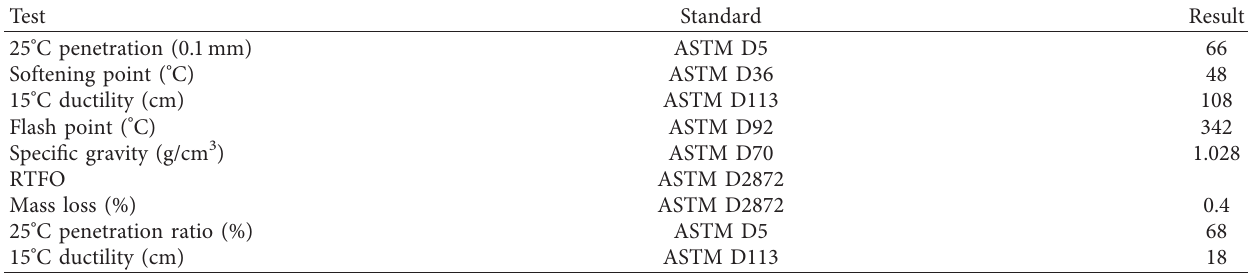
Table 1: Physical properties of AH-70 asphalt.